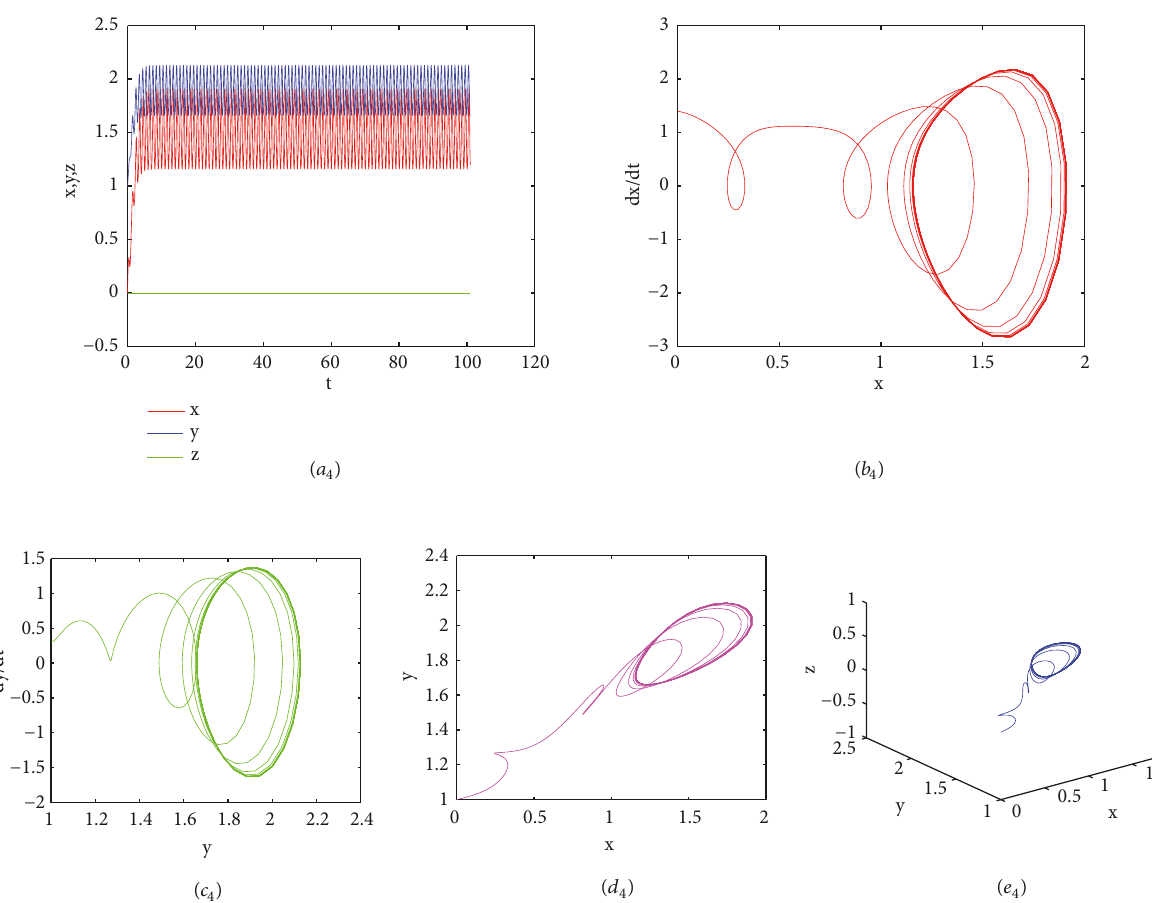
Figure 13: The results of Experiment 6: (𝑎 4 ) time series plot of 𝑥,𝑦, 𝑧 ; (𝑏 4 ) phase diagram of 𝑥 ; (𝑐 4 ) phase diagram of 𝑦 ; (𝑑 4 ) projected on the (𝑥,𝑦) -plane; (𝑒 ) on the three-dimensional space. 4